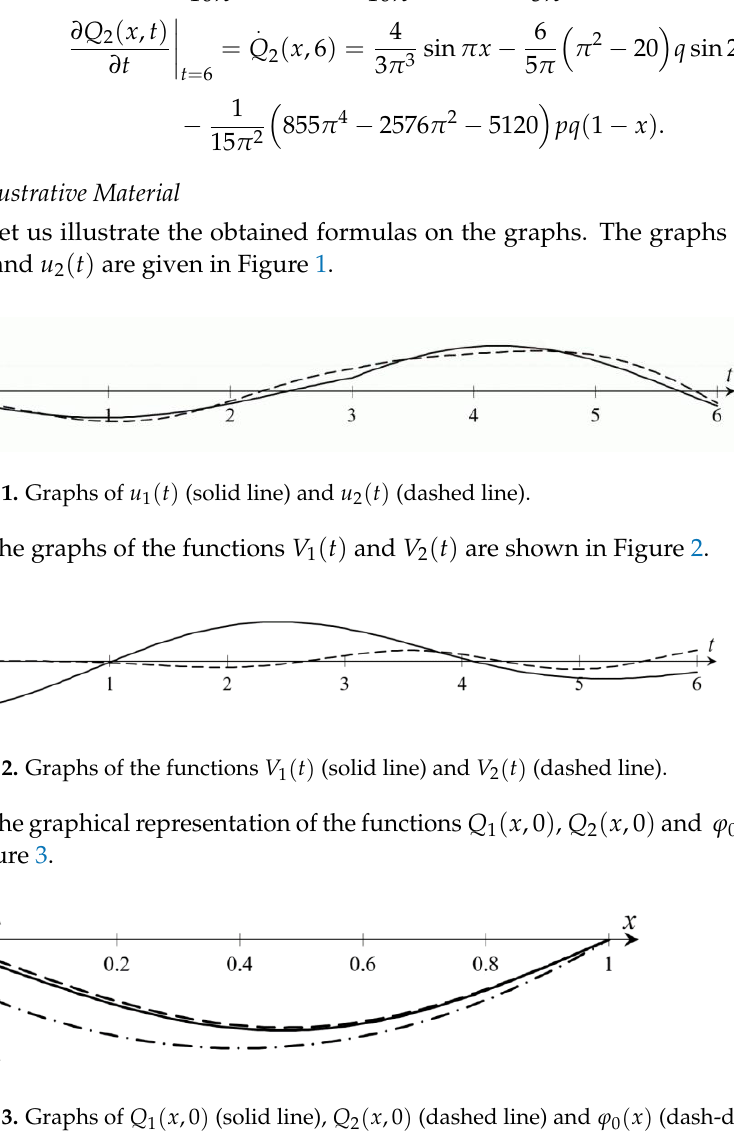
Figure 6. Graphs of 𝑄˙ 1 (𝑥, 6) (solid line) and 𝑄˙ 2 (𝑥, 6) (dashed line). Figure 7 provides graphical illustrations of the dynamics of the behavior of the func- tions 𝑄 1 (𝑥, 𝑡) and 𝑄 2 (𝑥, 𝑡) given 𝑡 = 0, 1, 2, 3, 4, 5, 6 . ( a ) ( b ) ( c )